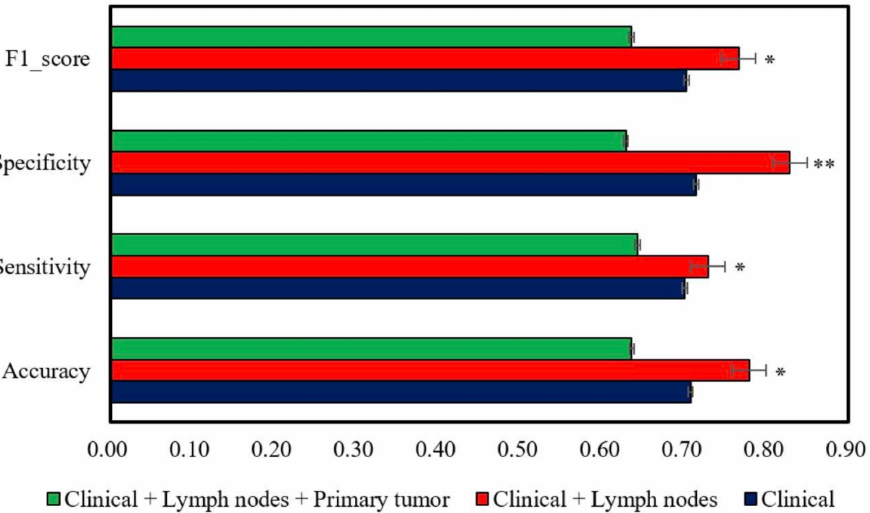
Figure 7. The efficiency of accuracy, sensitivity, and specificity values is the highest when using the combination of clinical data and lymph nodes to predict neck recurrence. * significant, ** highly